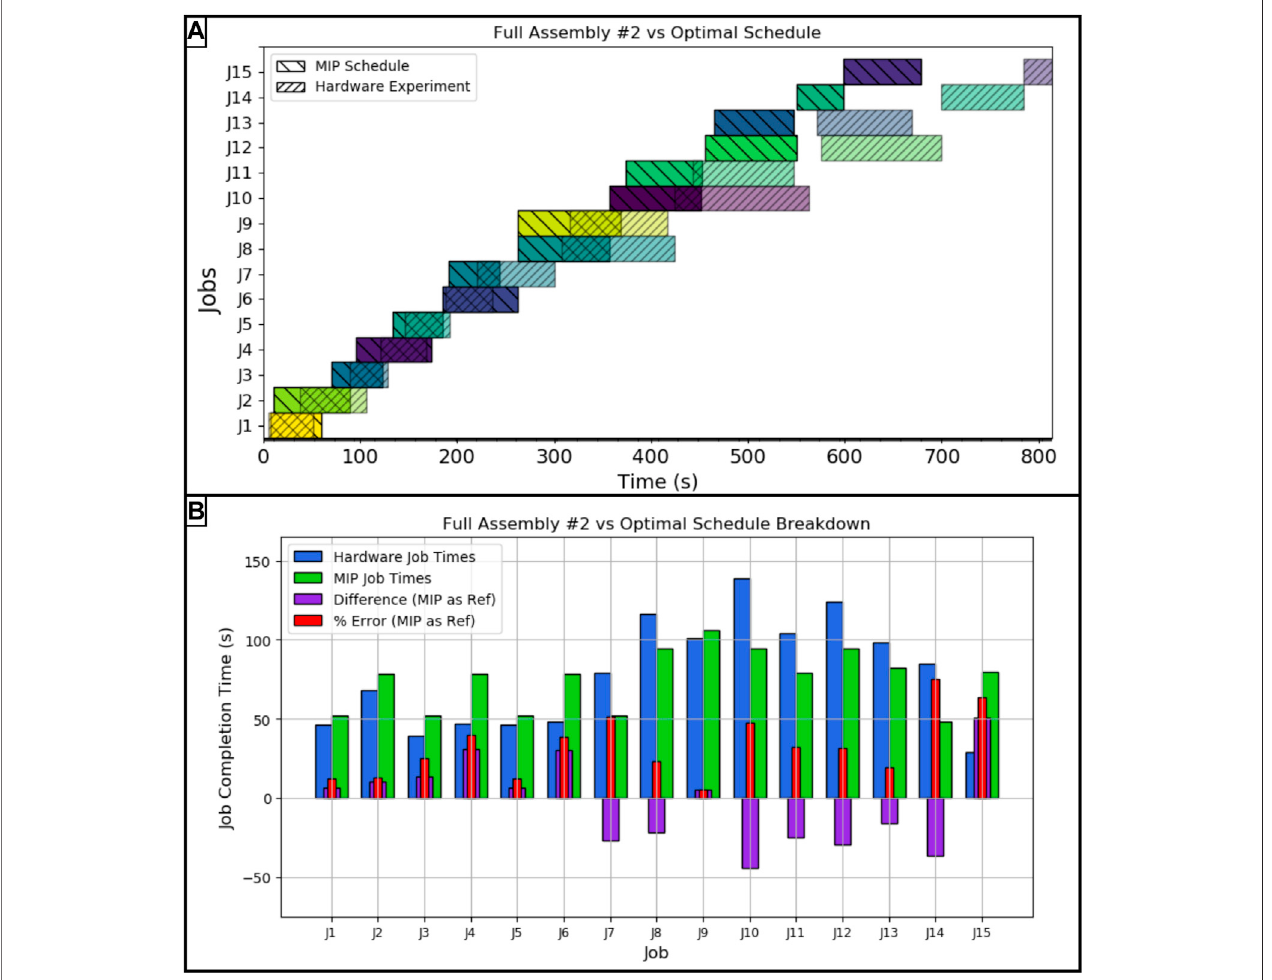
FIGURE 6 | (A) Hardware vs MIP optimal schedule for the second full assembly run, (B) Job by job breakdown with error for the second full assembly run. The job key is as follows: J 1: Mlb 2, J 2: Mlb 1, J 3: Mmb 2, J 4: Msbm 1, J 5: Mmb 1, J 6: Msbc 2, J 7: Msbc 1, J 8: Cmb 1 lb 1, J 9: Csbm 1 sbc 1, J 10: Cmb 2 lb 2, J 11: Mmb 1 lb 1, J